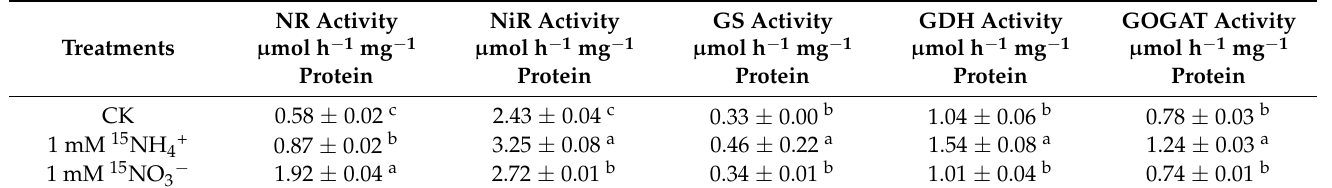
Table 2. Activities of N assimilation enzymes in the roots of T. distichum under three N treatments.